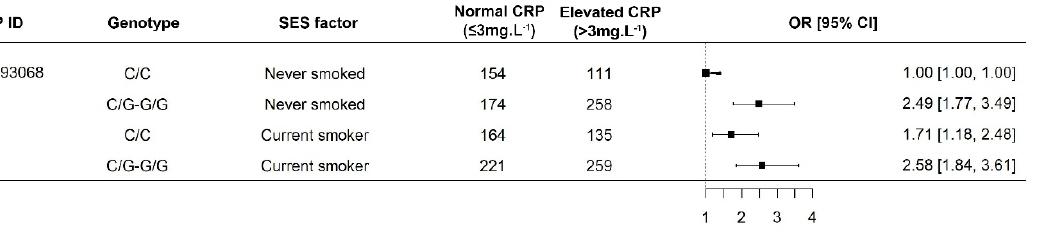
Figure 1. Interaction between tobacco smoke and rs3093068 in the Prospective Urban and Rural Epidemiologystudy—NorthWestarm. TheminoralleleisassociatedwithincreasedCRPconcentrations, which are further increased in smokers. Men were more likely to be current smokers (59.5% vs. 47.6%; p < 0.0001). Homozygous smokers for the minor allele had a 71% increased risk of presenting with elevated CRP concentrations. Abbreviations: CRP, C-reactive protein; C, cytosine; CI, 95% confidence interval; G,